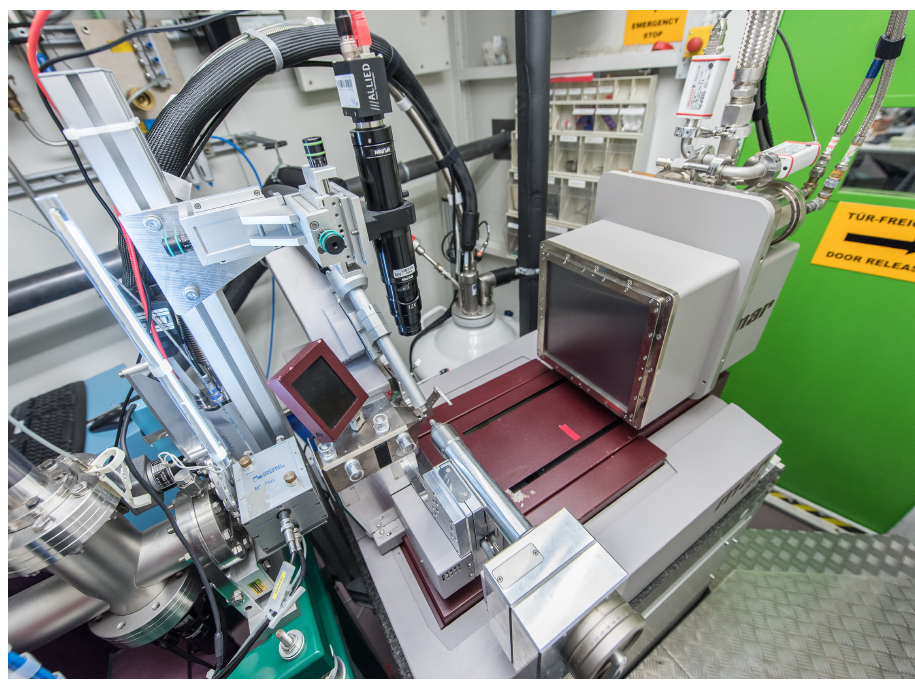
Figure 3: Experimental station of beamline